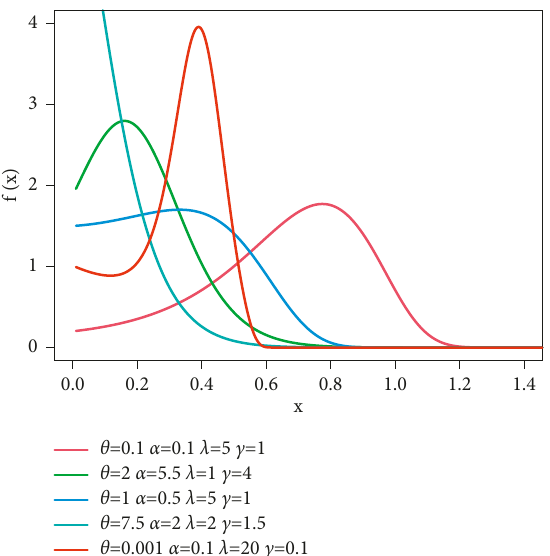
Figure 1: The p.d.f. plot for the MOEGM model.